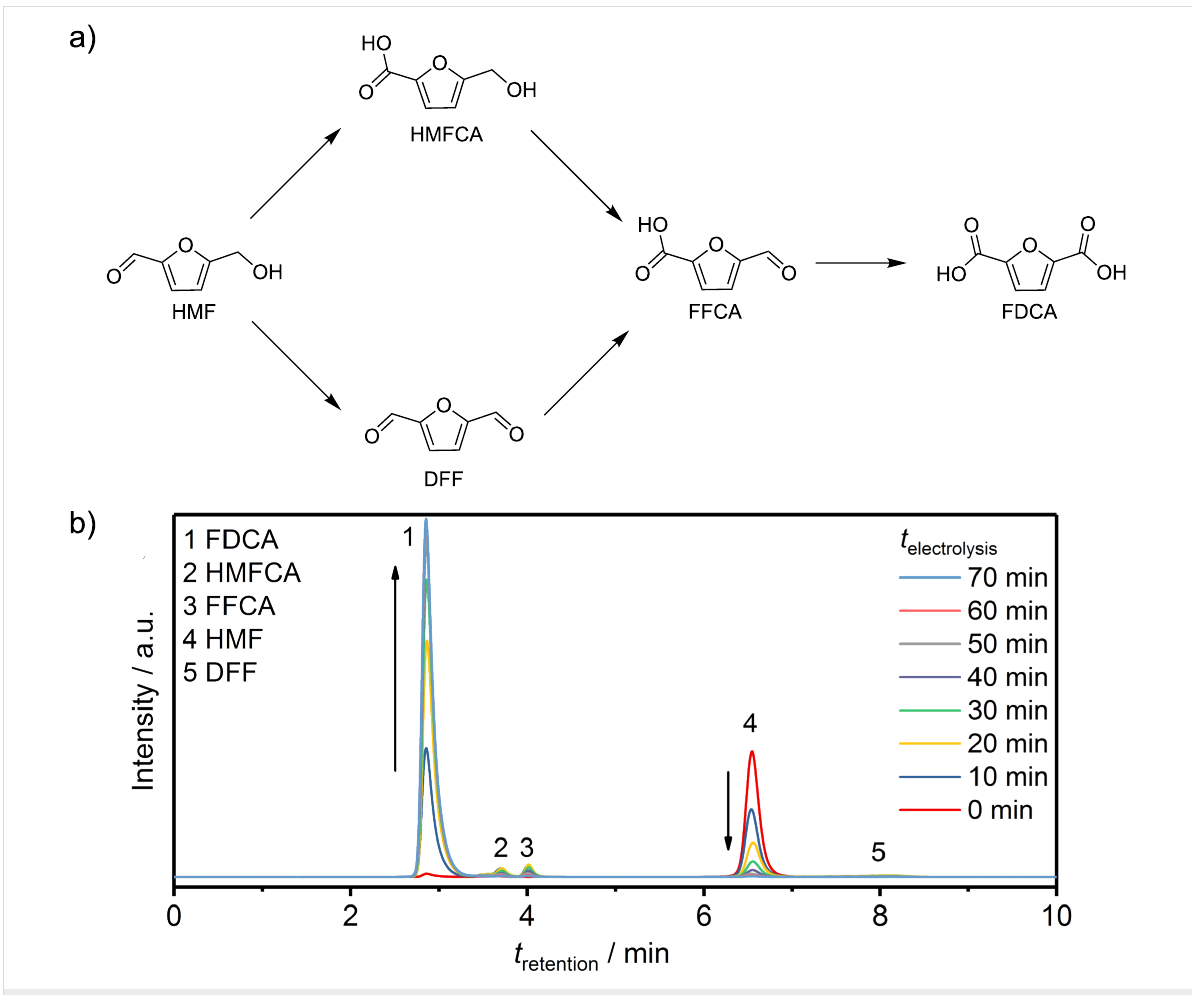
Figure 4: a) Reaction pathways of HMF oxidation; b) chromatograms at various times during constant potential electrolysis at 1.45 V vs